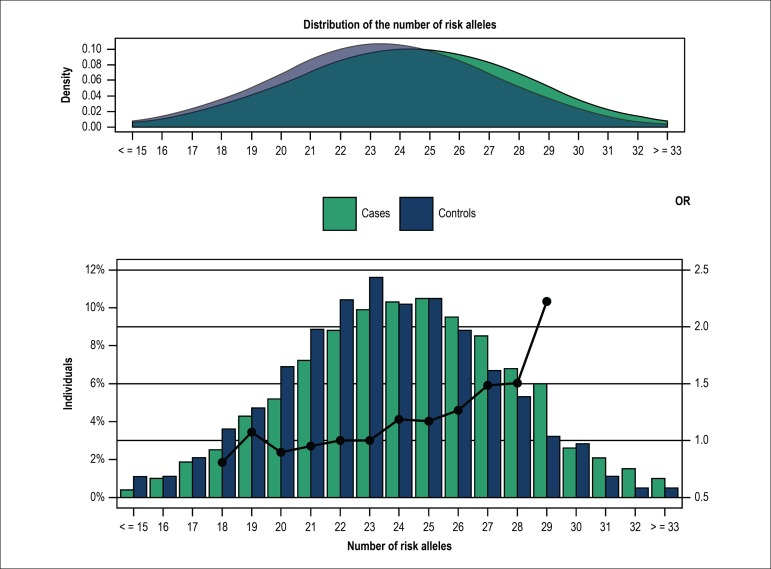
Distribution of the number of risk alleles by cases and controls. A
logistic regression model was used to determine the coronary artery
disease risk by the number of risk alleles compared to the number of
reference alleles (23 alleles, in relation to the median value of
the controls). Dots: regression analysis odds ratio for coronary
artery disease.